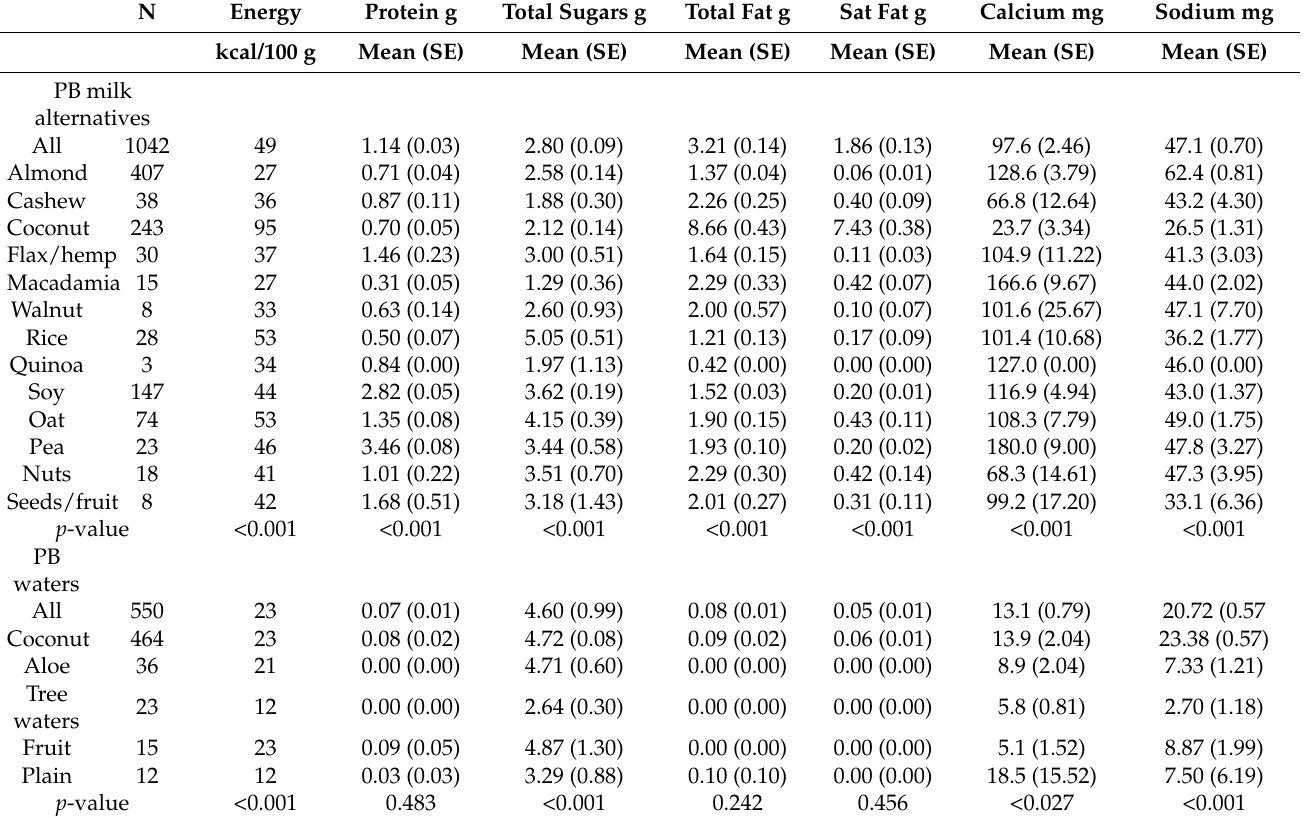
Table 3. Energy and nutrient content per 100 g of PB milk alternatives and PB waters by product type and main ingredient. Data are means (SE). Significance tests ( p -values) are for column